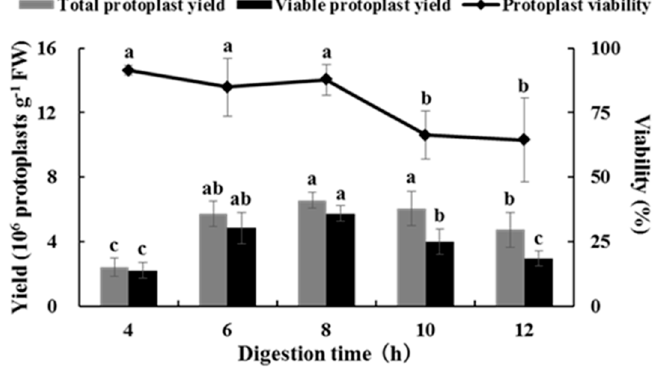
Figure 2. Effects of digestion time on total yield and viability of Chinese kale hypocotyl protoplasts.